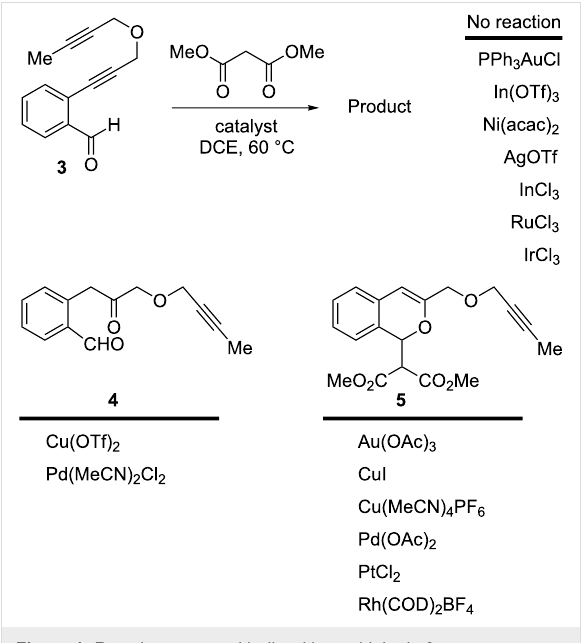
Figure 1: Reaction screen with diynyl benzaldehyde 3